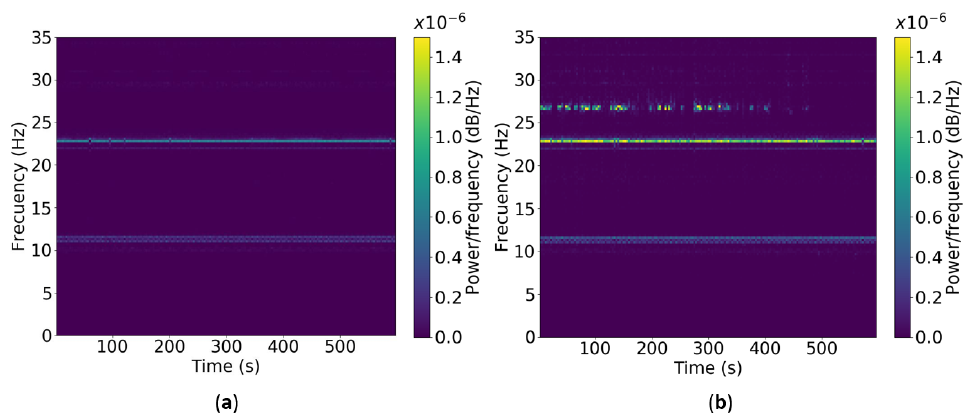
Figure 25. Time–frequency distribution of the response from the lightweight RC slab corresponding to the span 1–2: ( a ) Spectrogram of the ambient vibration. ( b ) Spectrogram of the forced